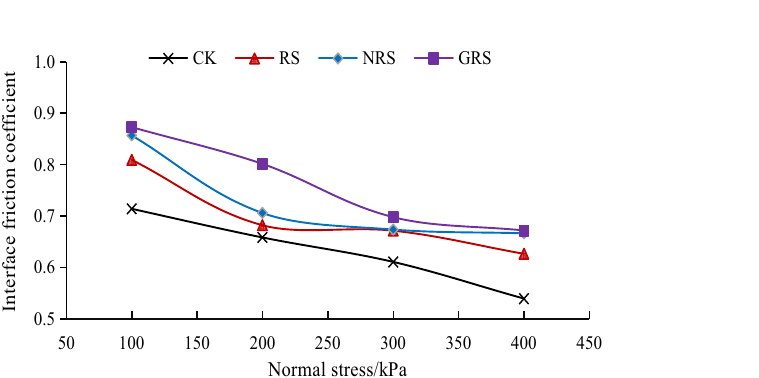
Figure 6. Relationship between shear index of the interface between A. fruticosa root and tailings soil.